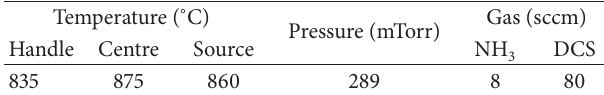
Table 1: LS SiN deposition parameter.